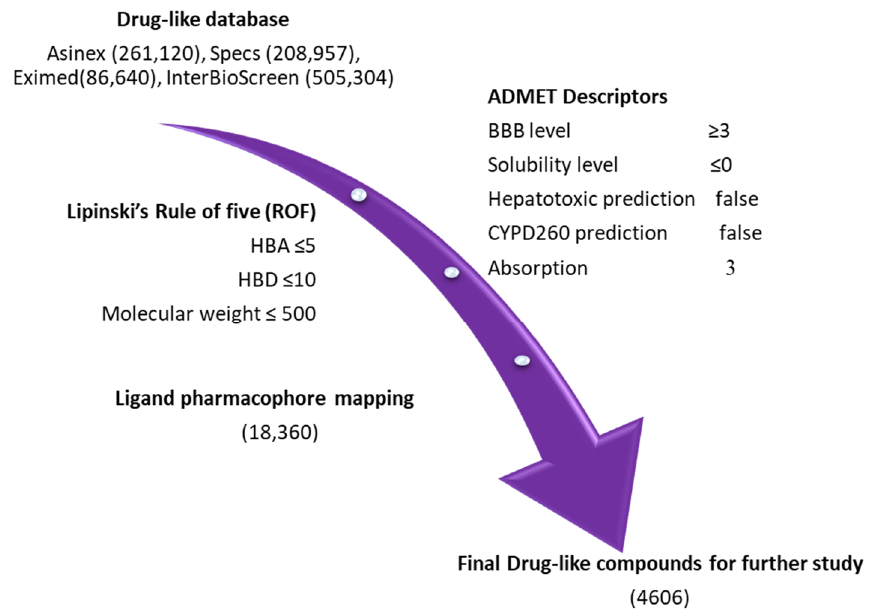
Figure 4. Pharmacophore-based virtual screening: four databases, namely Asinex, Eximed, Specs, and InterBioScreen, were sorted out using the ROF and ADMET descriptors tool, available in DS.